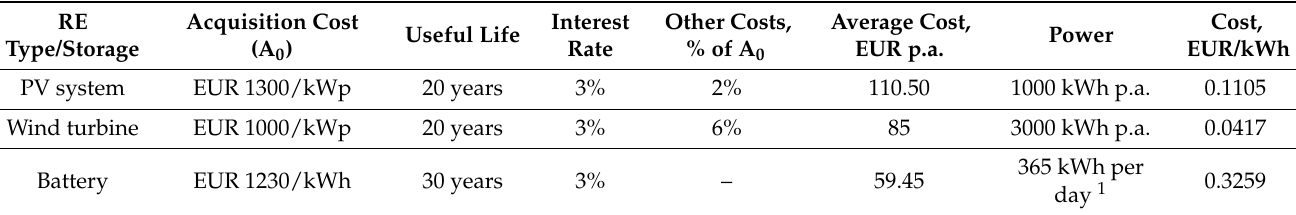
Table 1. Cost calculation for generation and storage of renewable electricity.